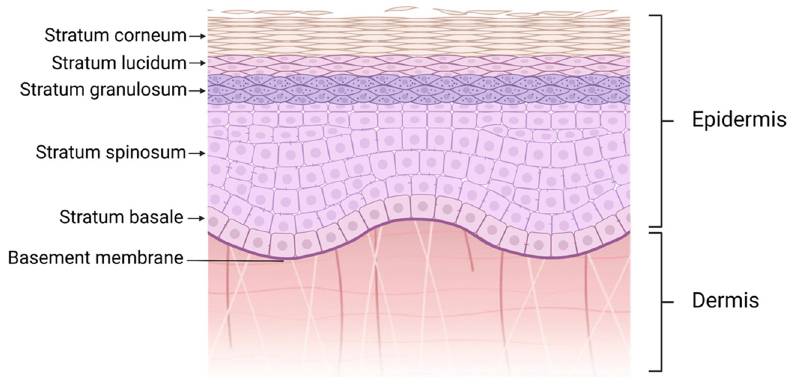
Figure 1: Normal structure of skin. Normal skin tissue consists of the epidermis and dermis. The epidermis is divided into a corneous layer, transparent layer, granular layer, spinous layer, and basal layer from outside